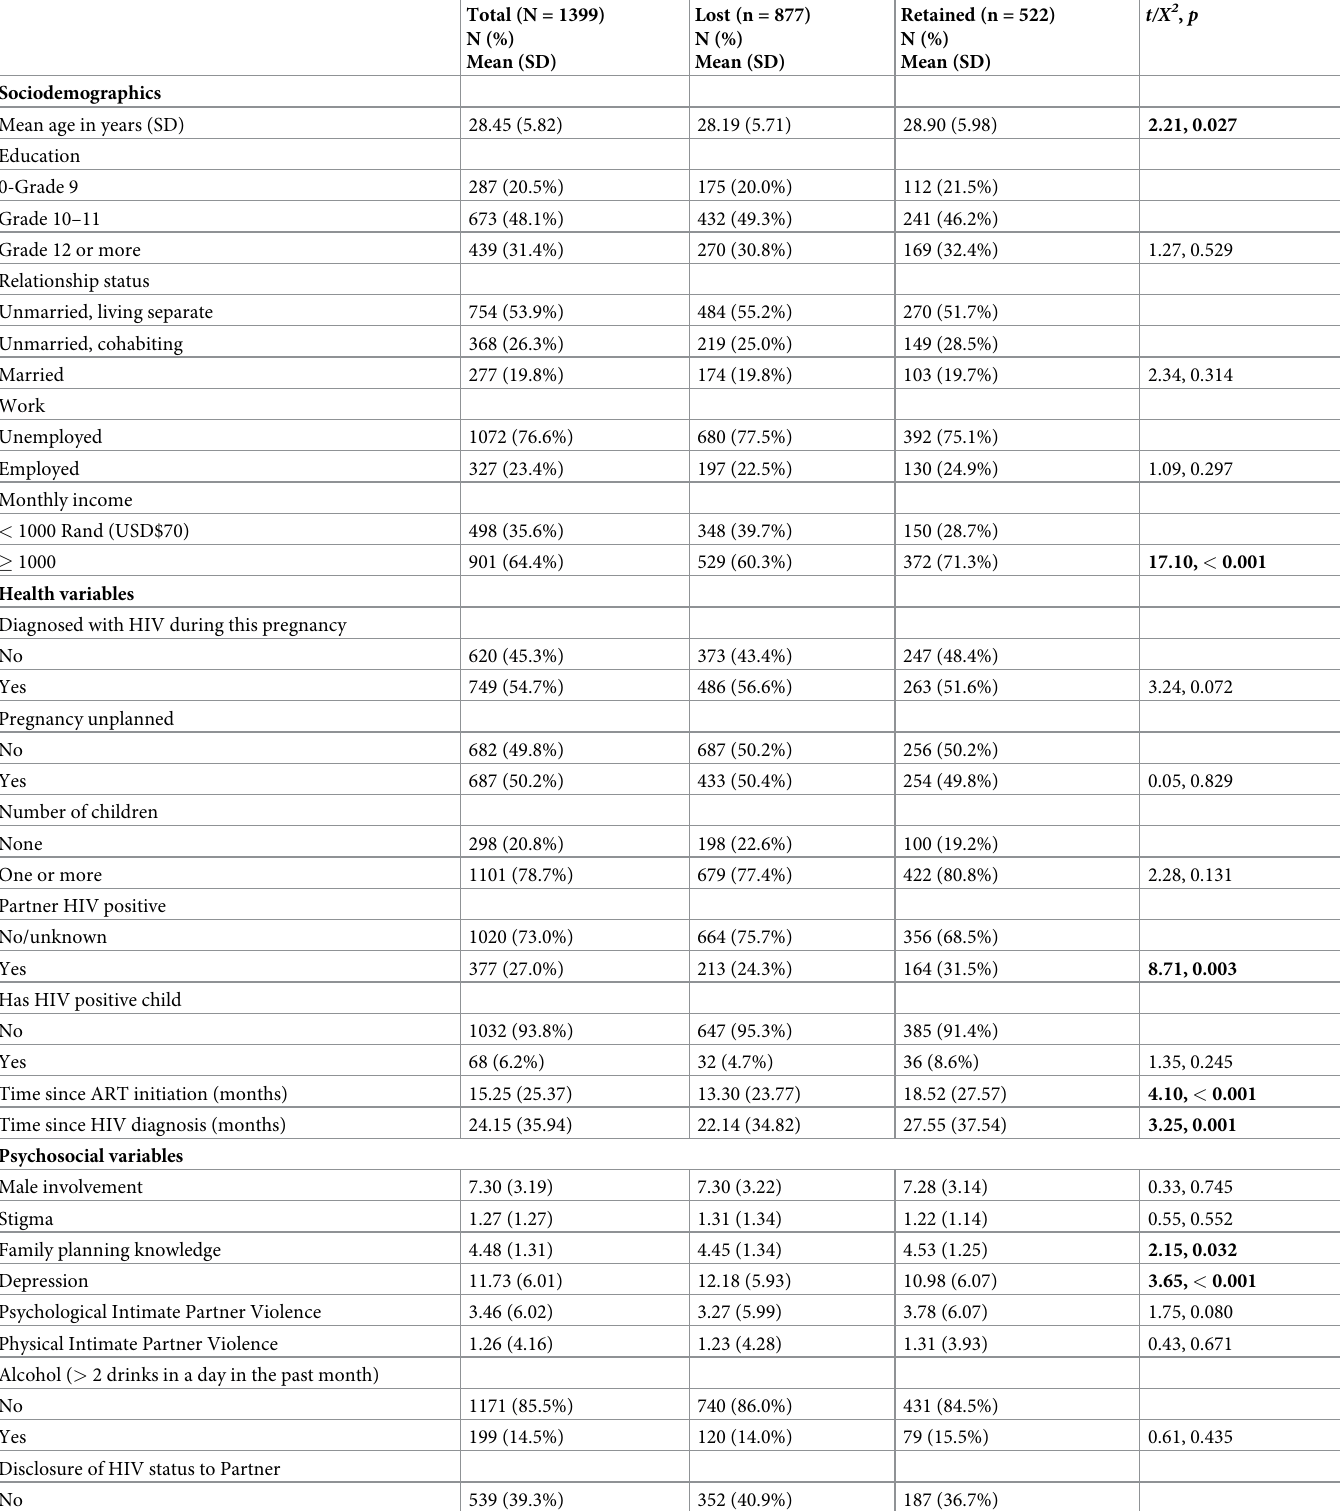
Table 1. Bivariate associations with attrition (N =